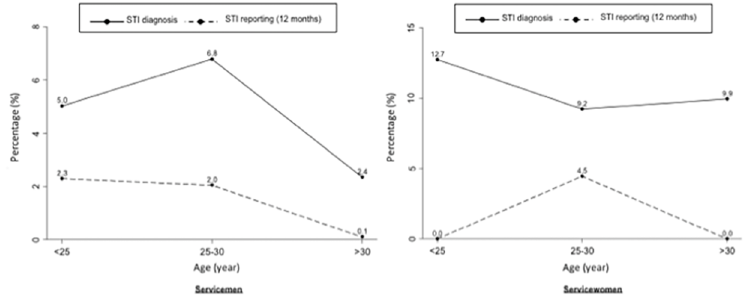
Fig 2. Prevalence of STI diagnosis and STI reporting (12 past months) according to gender and age class, COSEMIL